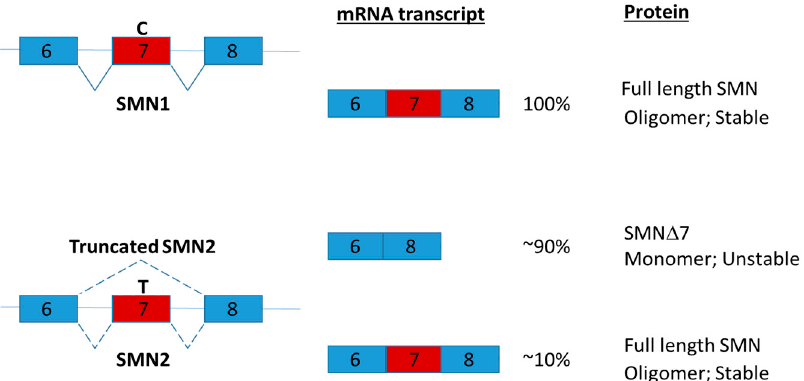
Figure 8. Human SMN1 and SMN2 genes are located respectively in the telomeric and centromeric region of chromosome 5. The single nucleotide difference in exon 7 (C or T as indicated) of SMN1 and SMN2 gene affects their splicing. The single nucleotide change from C to T drastically reduces the efficiency of exon 7 inclusion and increase the production of the truncated mRNAs and proteins [121]. SMN has been shown to self-associate and functions as an oligomer [117]. The stability of SMN protein is highly influenced by oligomerization [119]. The splice variant lacking exon 7 (SMN ∆ 7) impairs oligomerization leading to rapid degradation of SMN [119]. SMN2 is present in all SMA patients. Splice intervention therapies promote SMN2 exon 7 retention offer a promising approach for SMA therapy by increasing the amount of full-length SMN2 transcript [122].